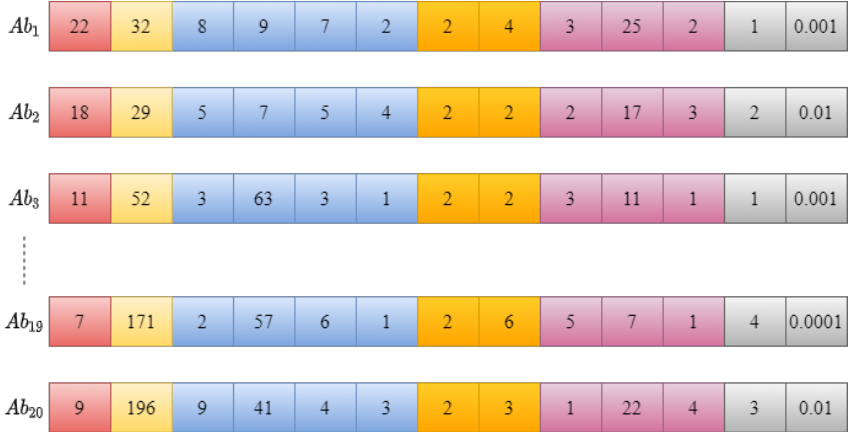
Figure 4. A randomly generated initial population of antibodies (CNN